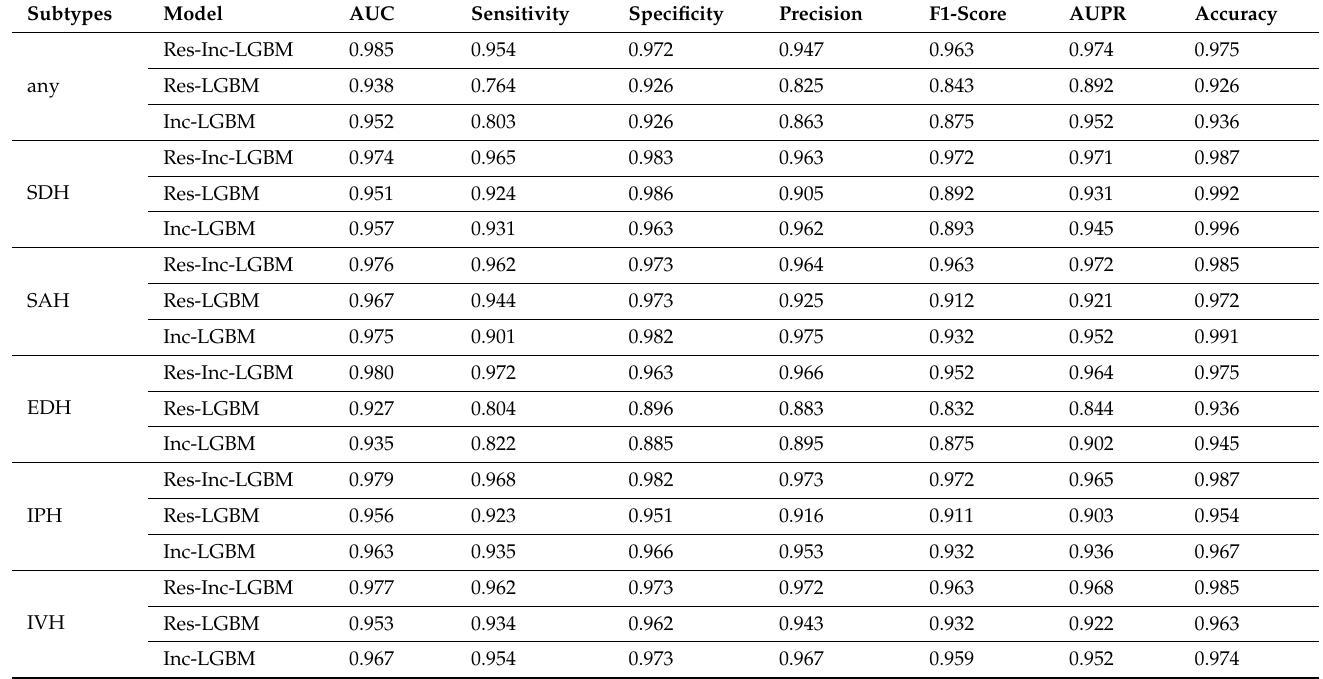
Table 2. ICH detection and subtype classification results of the proposed solution using the IHDC